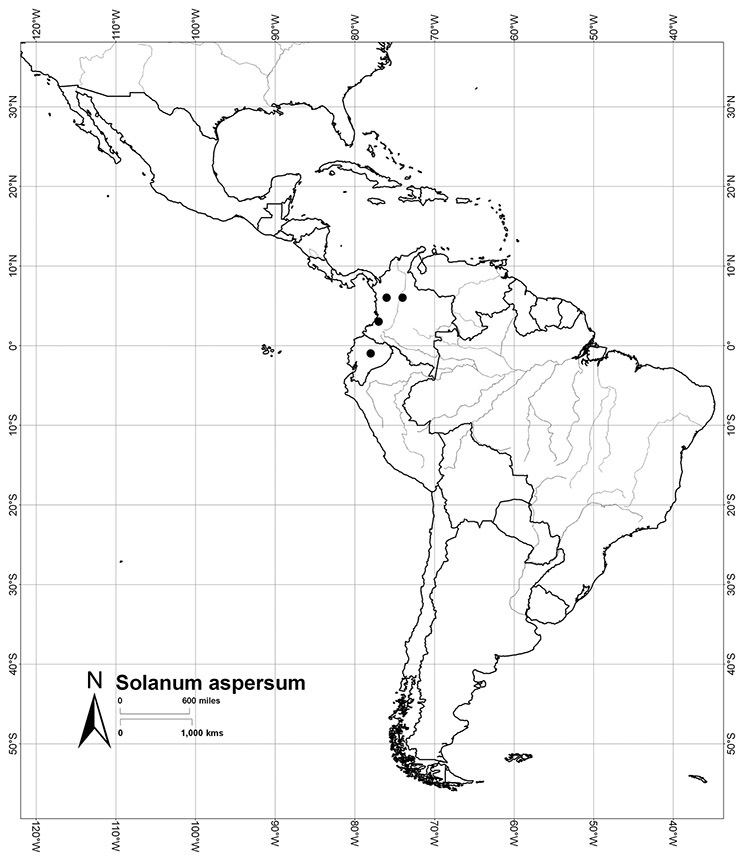
Distribution of Solanum aspersum S.Knapp